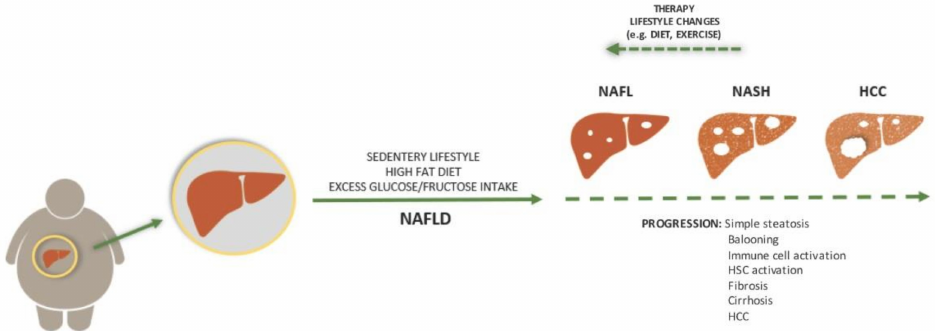
Figure 1. Aetiology and progression of non-alcoholic fatty liver disease (NAFLD). In most cases, NAFLD is a consequence of sedentary lifestyle, a high fat diet, and excess glucose/fructose intake. While the state can be completely reversed with a lifestyle change or therapy, its progression is driven by pathological processes that result in histologically visible steatosis, ballooning, fibrosis, and cirrhosis. Each step is accompanied by immune cell activation while later steps include hepatic stellate cell activation. The end stage of this process can be hepatocellular carcinoma (HCC). A subsequent step through which severity of NAFLD can be assessed is